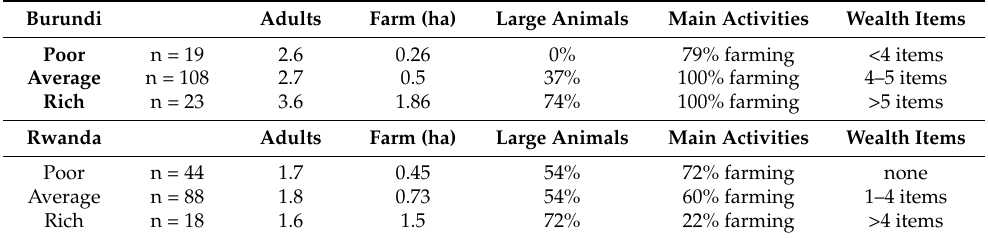
Table 1. Household characteristics of the participants in this study. Large animals referred to pigs (54% and 53% of the respondents in Burundi and Rwanda, respectively), cows (32% and 31%), or goats (0% and 1%).